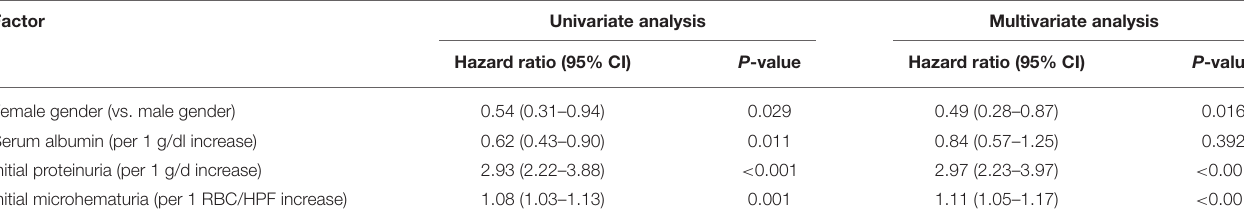
TABLE 5 | Univariate and multivariate analyses of independent prognostic factors of nephrotic proteinuria progression. Factor Univariate analysis Multivariate analysis Hazard ratio (95% CI) P -value Hazard ratio (95% CI) P -value Female gender (vs. male gender) 0.54 (0.31–0.94) 0.029 0.49 (0.28–0.87) 0.016 Serum albumin (per 1 g/dl increase) 0.62 (0.43–0.90) 0.011 0.84 (0.57–1.25) 0.392 Initial proteinuria (per 1 g/d